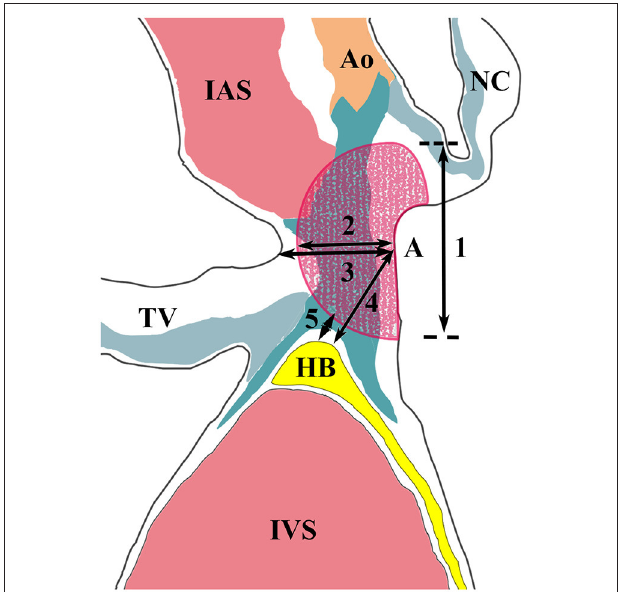
FIGURE 3 | Measurements of the ablation lesion and its related conduction tissue injury. Segments 1 and 2 represent the diameter and depth of the ablation lesion. Segment 3 represents the thickness of the interventricular septum at the ablation site. Segment 4 shows the distance between the ablation site and the His bundle. Segment 5 represents the shortest distance between them. Ao, aorta; HB, His bundle; IAS, interatrial septum; IVS, interventricular septum; NC, non-coronary leaflet; TV, tricuspid valve.